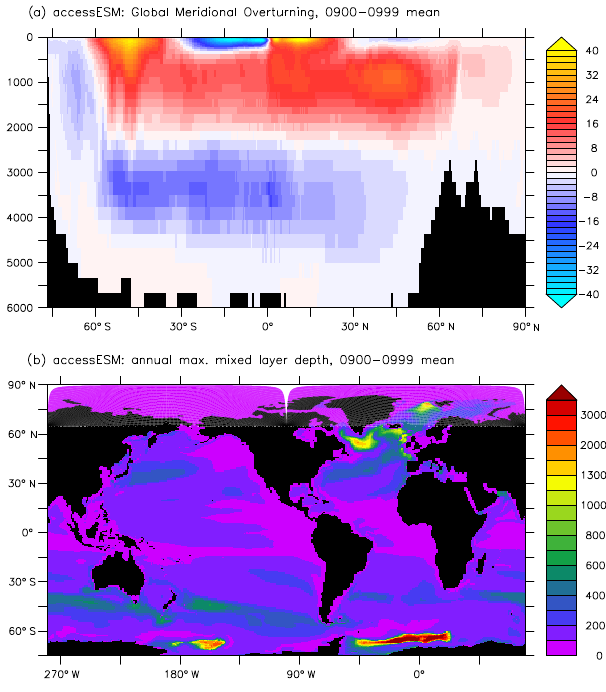
Figure 3. ACCESS-ESM1 from the last 100-year average of the pre-industrial simulation for (a) global meridional overturning stream function (Sv) and (b) maximum annual mixed layer depth